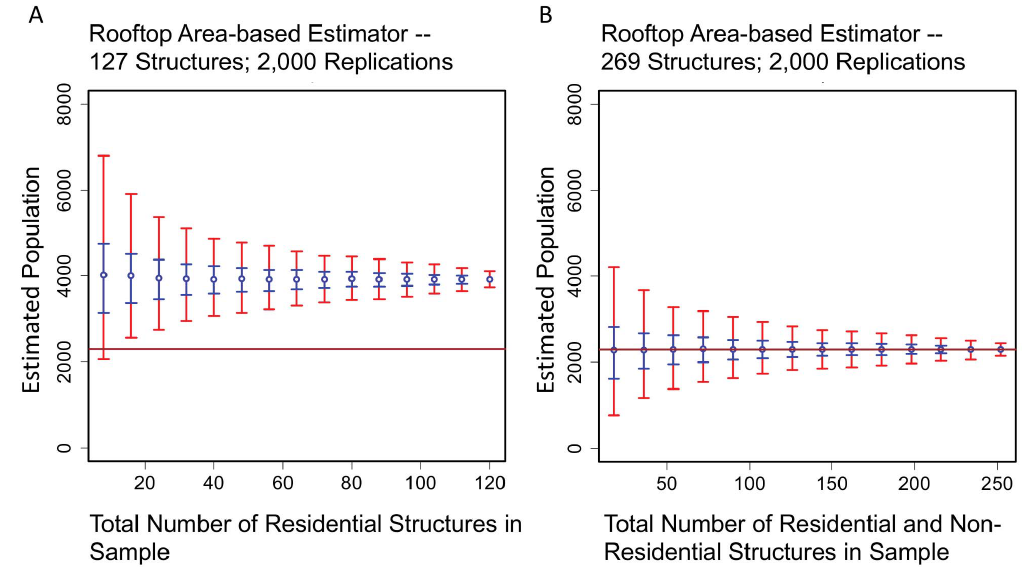
Figure 7. Rooftop area-based population estimations for Njai Town using invalid and valid scale factors. (A) Non-convergent rooftop area-based population estimate with 0.50 (blue) and 0.95 CIs (red). Samples were drawn from the Njai Town dataset of 127 residences only, but the scale factor Total { Area was set to the rooftop area for all 269 structures ( As ). (B) Convergent rooftop-based population estimate with 0.50 (red) and 0.95 (blue) CIs. Samples were drawn from the Njai Town dataset of 269 residential and non-residential structures, and Total { Area was set correctly set to As . Source: residential survey data and digitized rooftop areas, As =37,358 m 2 .